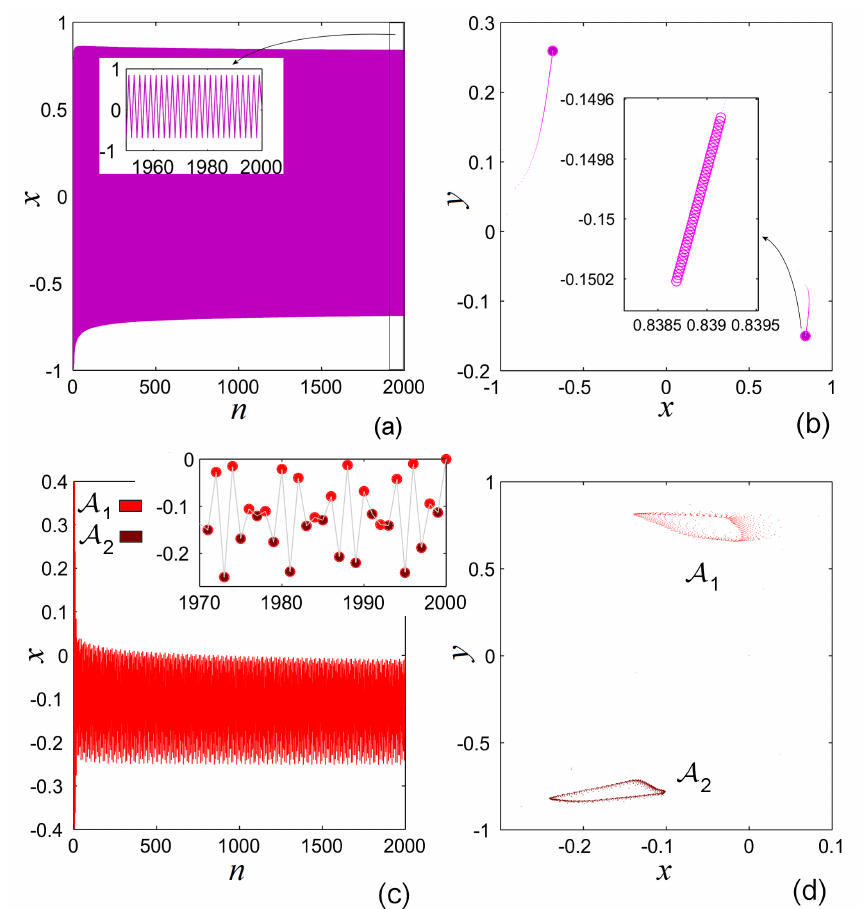
Figure 8. Two orbits of the DLM of FO for q = 0.1. ( a ) Time series of a periodic-like orbit from [ x ] = [ − 0.5, − 0.1 ] ; ( b ) phase portrait of the orbit and a zoom indicating the slow orbit conver- 0 , y 0 1 gence; ( c ) time series of a two-band quasiperiodic-like orbit from [ x 0 , y 0 ] 2 = [ 0.2,0.1 ] . The zoom indicates the alternate pattern of the orbit between the two subsets A 1 and A 2 (red and brown) of the quasiperiodic-like attractor; ( d ) phase portrait of the orbit [ x 0 , y 0 ] 2 = [ 0.2,0.1 ]